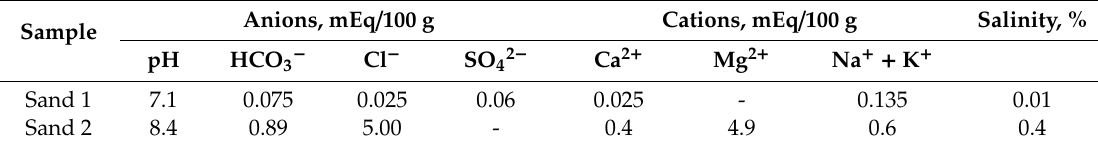
Table 2. Salinity and chemical composition of water extracts from investigated